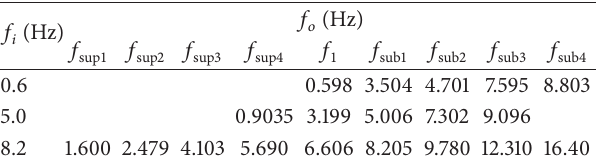
Table 2: Simulation output frequency.